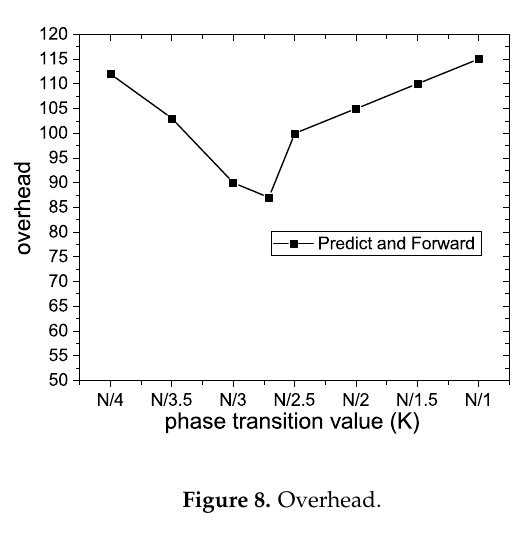
Figure 7. Delivery ratio.